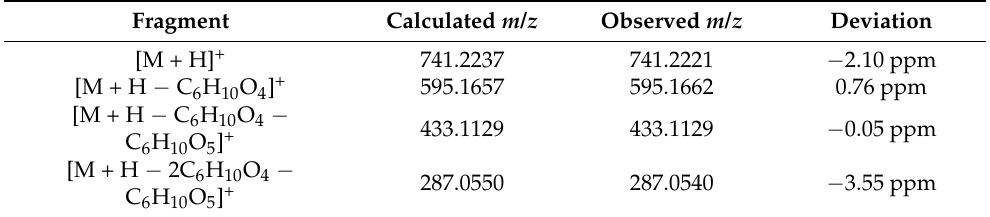
Table 1. The deviations between calculated and observed m / z values of each fragment derived from compound 1 .